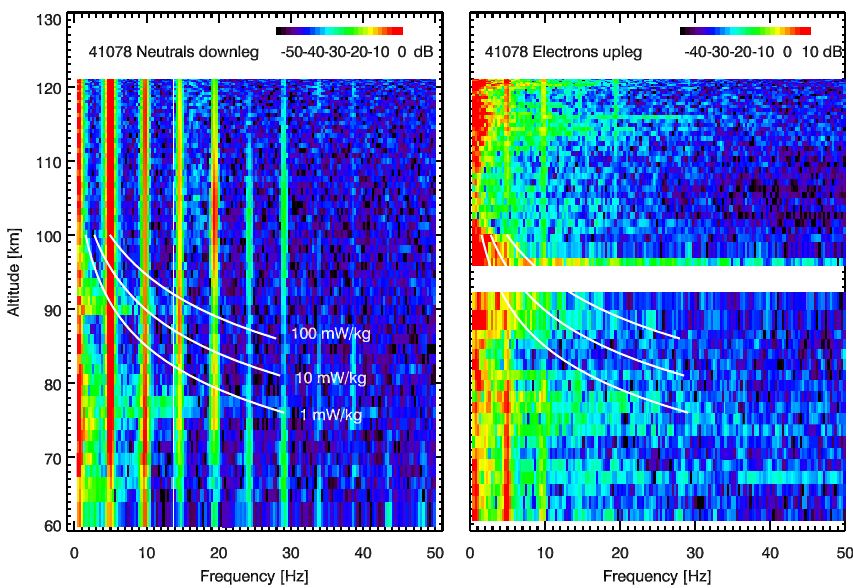
Fig. 6. Left: spectrogram of neutral density fluctuations for flight 41.078 on downleg, Right: same for nosetip probe electron fluctuations on upleg. The white curves are estimates where the fluctuation level drops off based on the inner scale of turbulence, payload velocity, and typical energy dissipation rates.